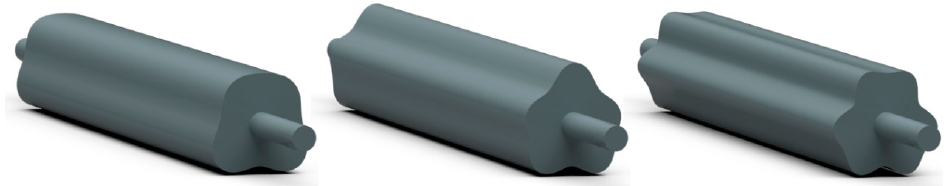
Figure 4. Rotors with harmonic roundness component pairs. On the left: components 3 and 4, in the middle: components 3 and 5, on the right: components 3 and 6.